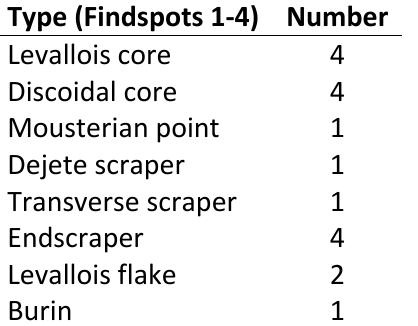
Table 2. The Middle Palaeolithic lithic collection.